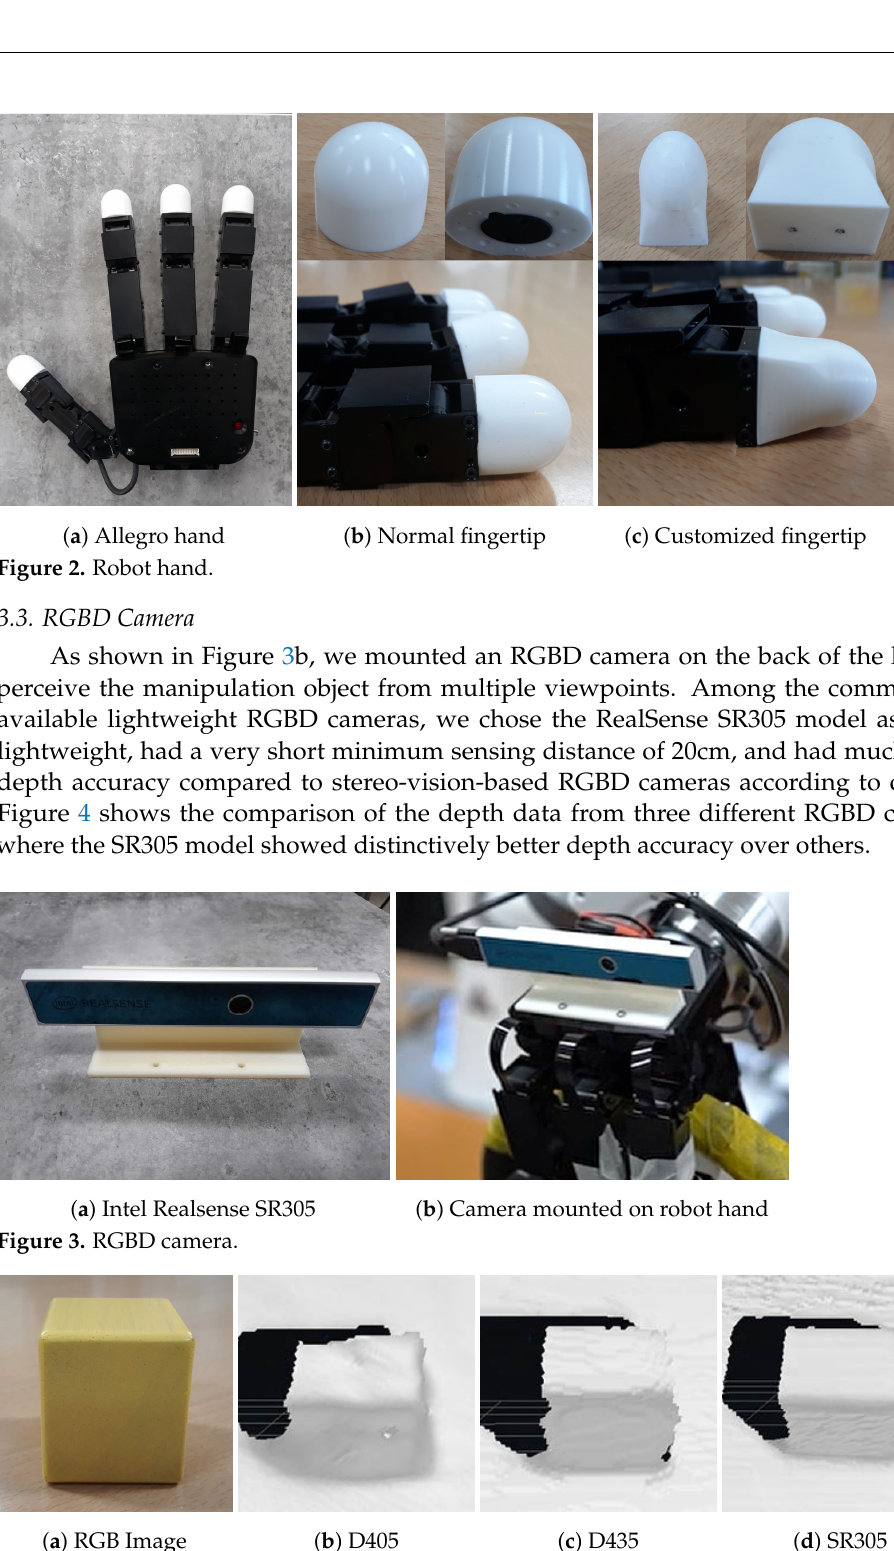
Figure 4. Point cloud data taken by three different RGBD